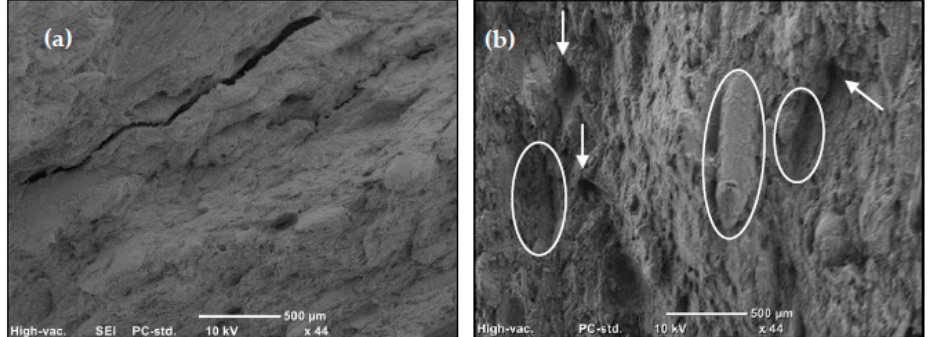
Figure 7. Flexural fracture surface before and after moisture uptake. ( a ) as-received 40WPC15; ( b ) conditioned 40WPC (at T = 40 °C and RH = 99%). See significance of the marks in the text. Table 5. Flexural properties of the nanocomposites with the moisture effect. The values 4% of strain and 25 MPa stress are selected as a common value to facilitate comparison between all samples.